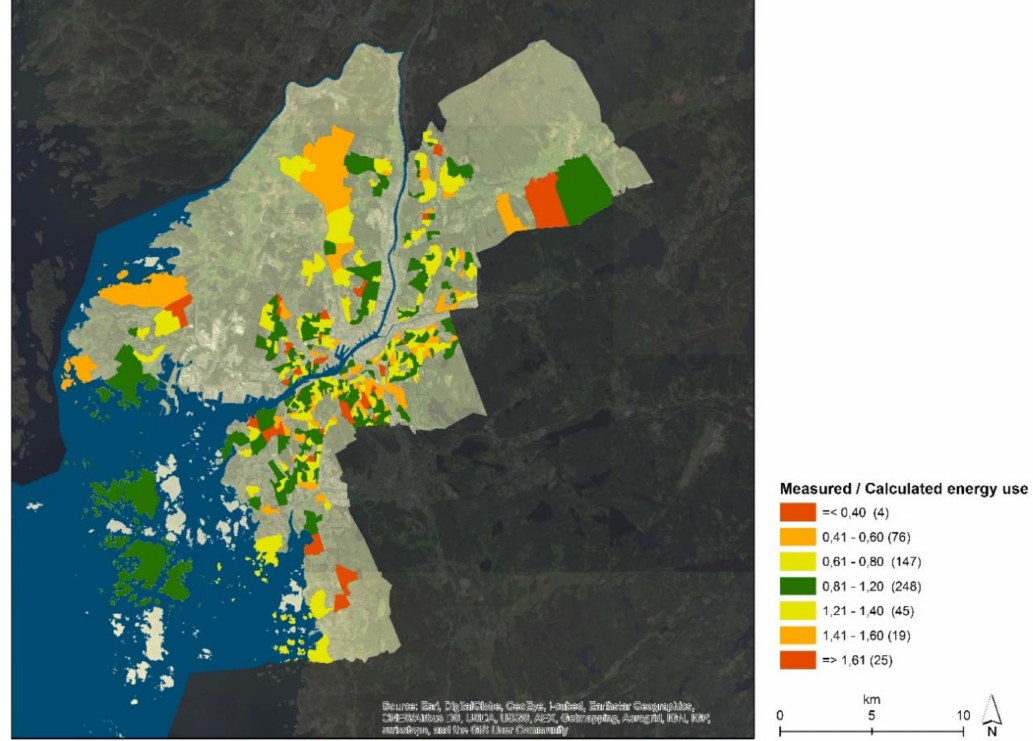
Figure 2. Visual validation of the BSM showing measured energy use in relation to calculated energy use for base areas. Numbers in brackets indicate number of